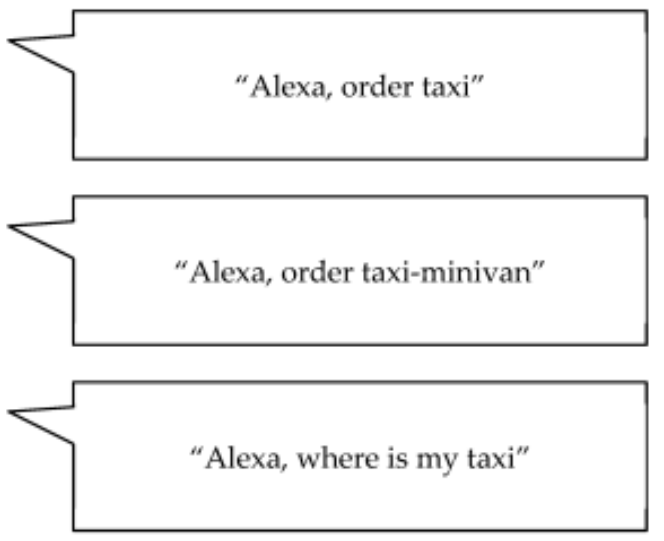
Figure 3. Standard